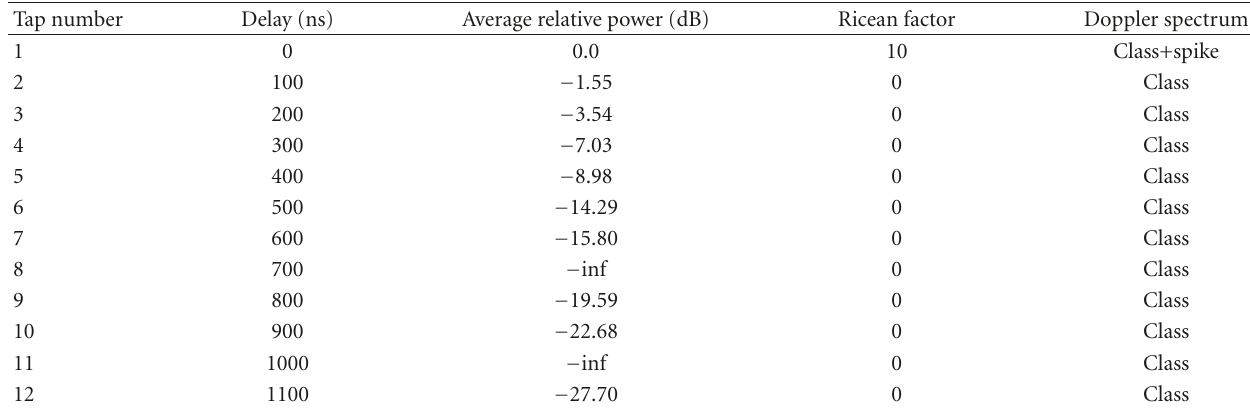
Table 2: Modified HIPERLAN/2 model D